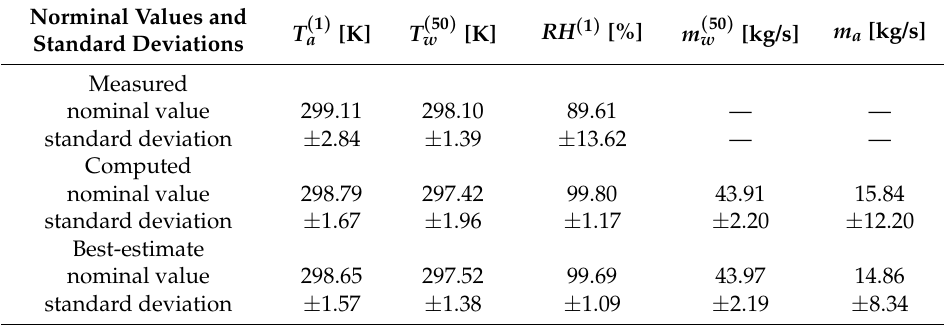
Table 13. Computed, measured, and optimal best-estimate nominal values and standard deviations for the outlet air temperature, outlet water temperature, outlet air relative humidity, outlet water mass flow rate and air mass flow rate